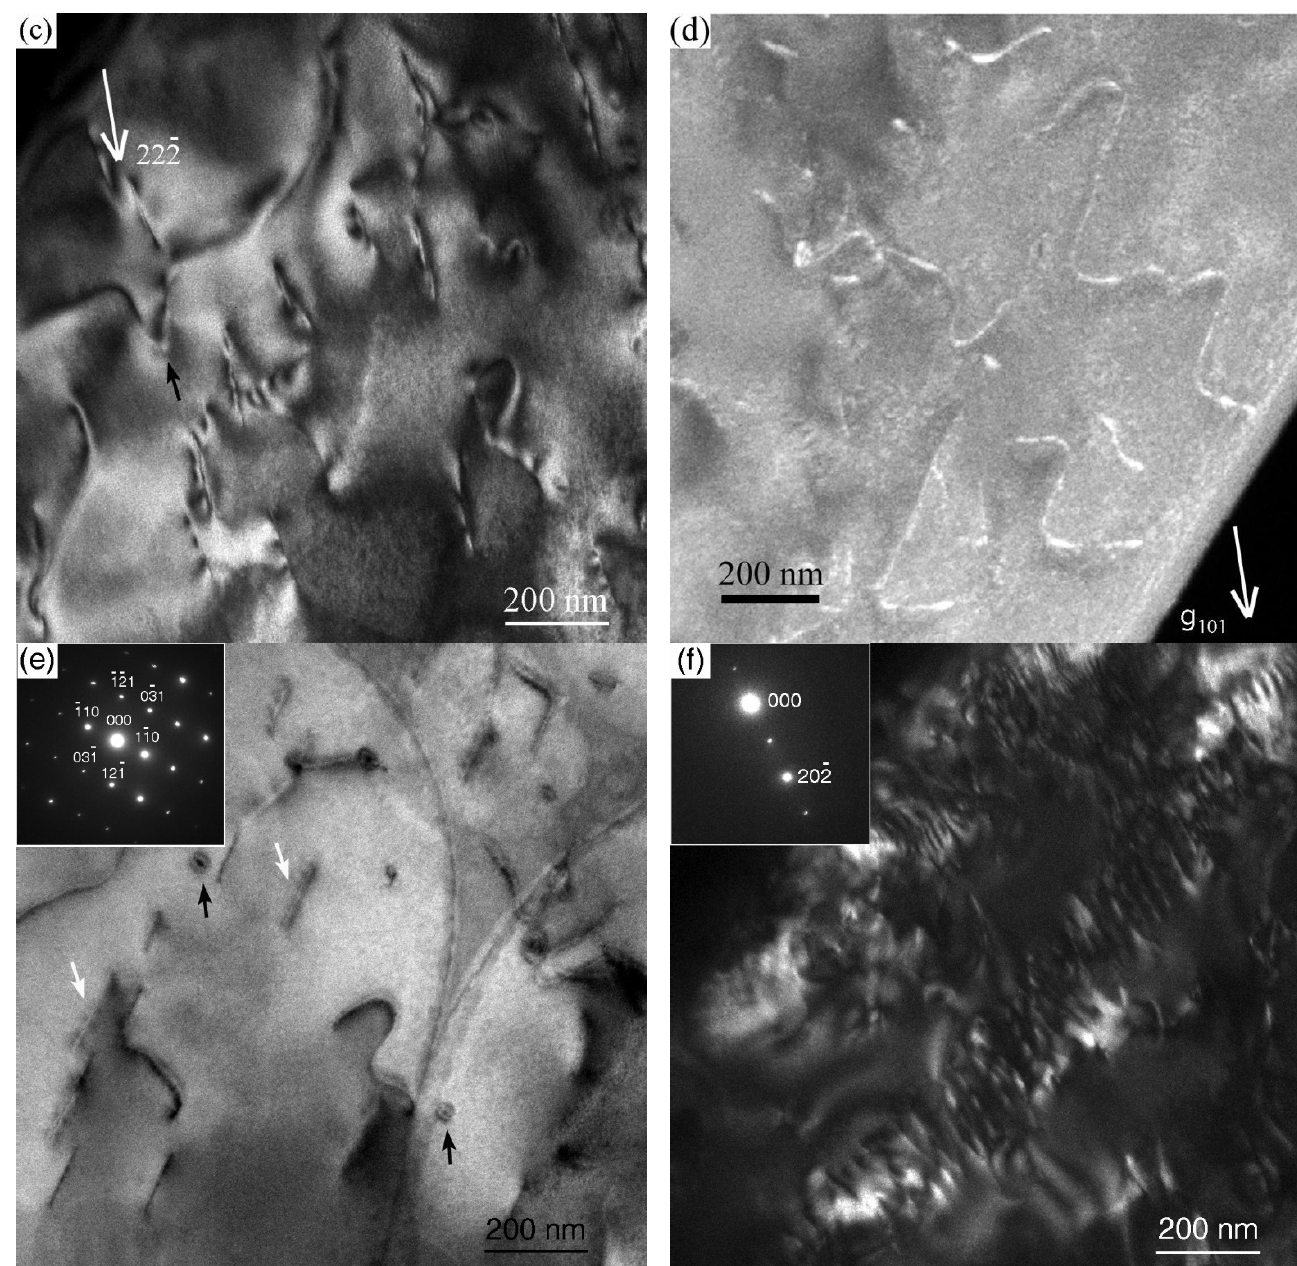
Figure 3. ( a ) Dark-field (DF) image with g101 (long white arrow indicated) taken in g/5g conditions. Short, straight [001] screw dislocations were dominant in the area. Movement of the dislocation dipoles introduced an intermediate jog, indicated by the short black arrow. Small loops are indicated by the short gray arrows. The curved mixed dislocation was split into partial dislocations, indicated by the short white arrow. ( b ) DF images with g 0-20 and g 1-10 obtained from the same area of ( a ). All dislocations were simultaneously out of contrast and were imaged in g/2g and g conditions, respectively. ( c ) DF image with g 22-2 obtained from the same area of ( a ), taken in g/2g conditions. An intermediate jog pinned the dipole trail in this image (indicated by the black arrow). ( d ) DF image with g 101 (indicated by the long white arrow) taken in g/5g conditions, showing curved mixed dislocations. ( e ) Bright-field (BF) image with [113] incidence showing small loops (such as those indicated by the short black arrows) and dissociated screw dislocations (such as those indicated by the short white arrows). The dissociation width varied from 10 to 15 nm. ( f ) DF image with g 20-2 taken in g/2g conditions. The dislocations’ walls were composed of arrays of screw dislocations.